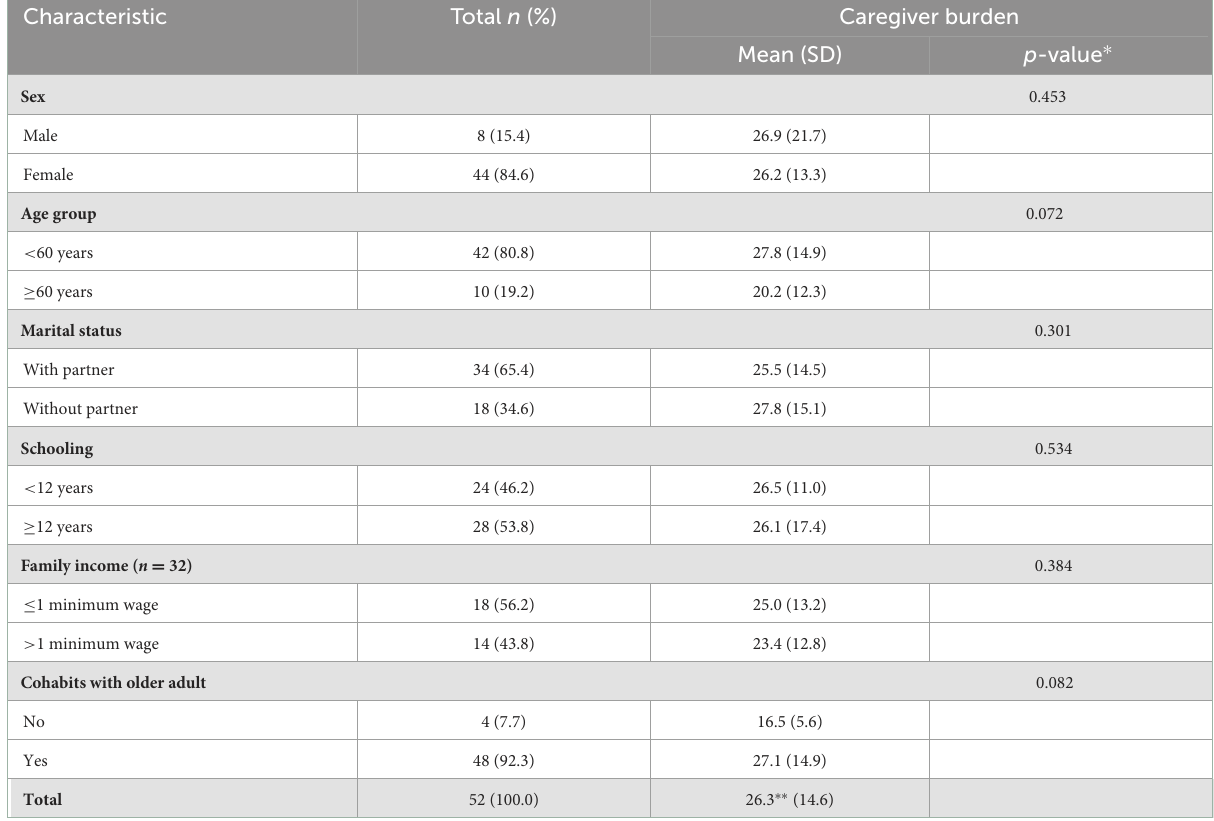
TABLE 1 Distribution of informal caregivers of older adults according to scores of burden and demographic, social, and economic characteristics. Palmas, Tocantins, Brazil ( n = 52).